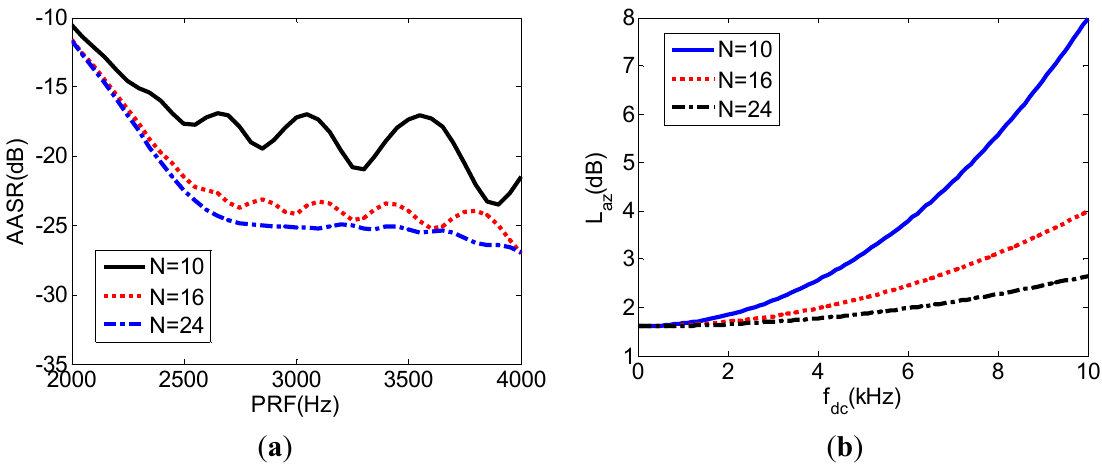
Figure 6. The TOPS timeline in the azimuth time-frequency diagram.